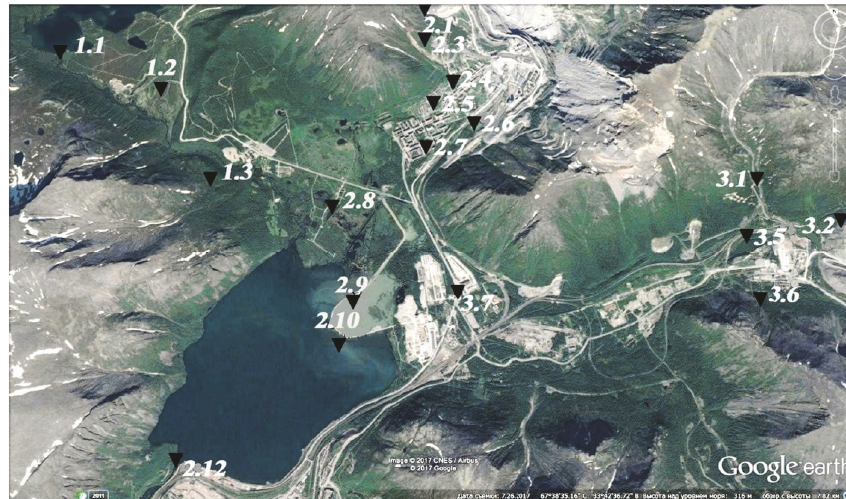
Figure 1: Region of research and sampling points.